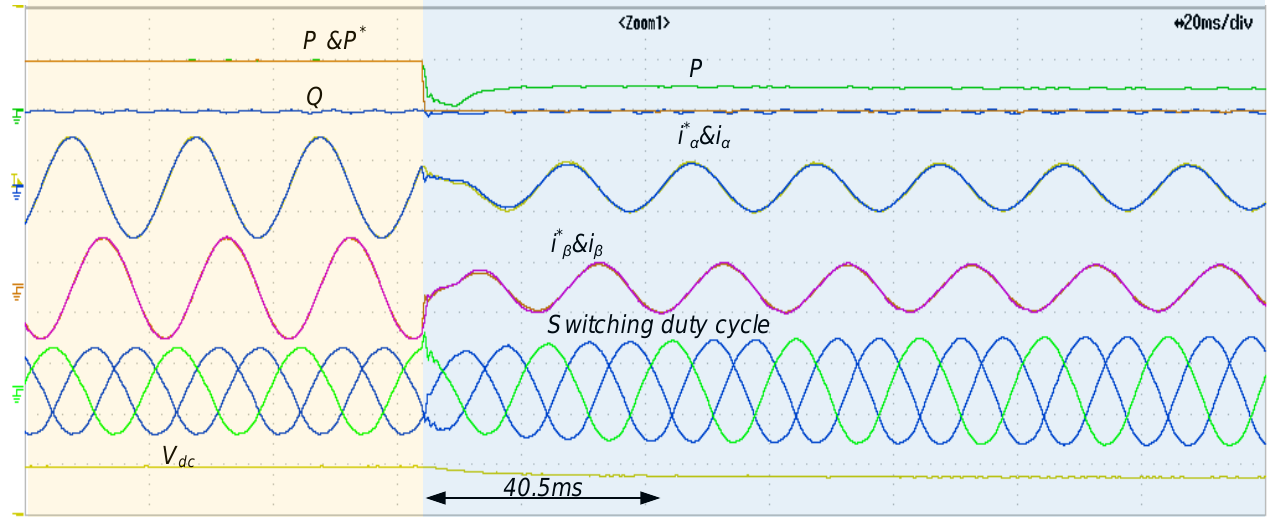
Figure 14. Real-time simulator results: active power reference step-down for BES-P2G. From top: active power reference ( P* , 10 kW/div), active power ( P , 10 kW/div), reactive power ( Q , 10 kVAR/div), actual and reference currents ( 𝑖 𝛼𝛽∗ &𝑖 switching duty cycle, DC link voltage ( V dc , 700 V/div).